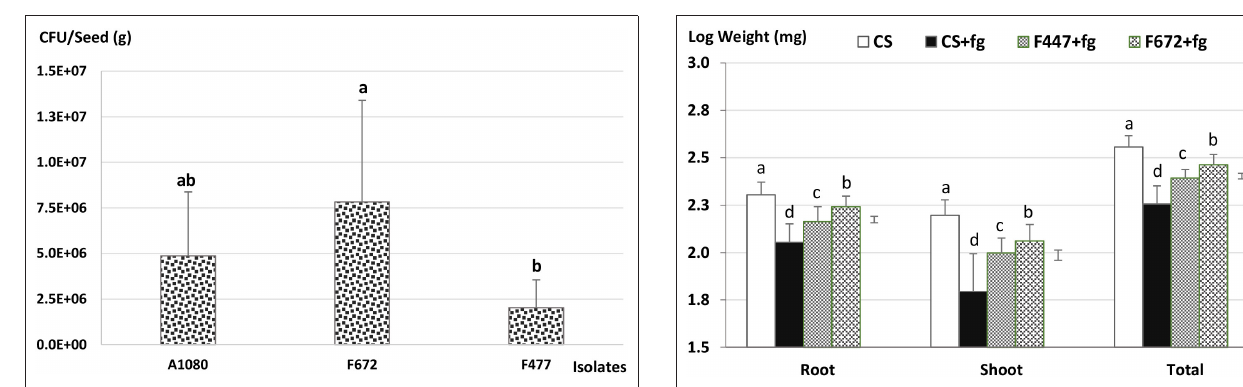
FIGURE 5 | Maize dry weight of three-week old potted plants from seeds coated with Metarhizium microsclerotia or coated without fungus (control seeds; CS) and grown in the absence or in the presence of Fusarium graminearum . Maize seeds were coated with microsclerotia from Metarhizium robertsii F447 or M. anisopliae F672 and sown in potting mix containing Fusarium graminearum . After 3 weeks, plants were harvested for the determination of dry weight. CS, control plants in absence of F. graminearum ; CSfg, control plants in presence of F. graminearum; F447 and F672, maize plants from seeds coated with microsclerotia from M. robertsii F447 or M. anisopliae F672, respectively. Error bars = standard deviation. Bars = LSD 5 % (Roots = 0.034; Shoots = 0.054; Total = 0.029); p <